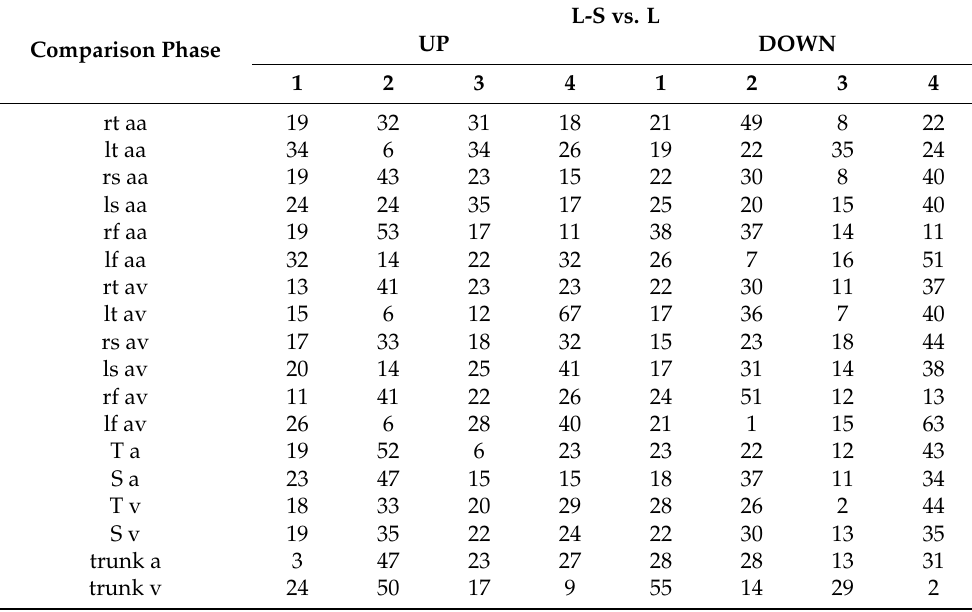
Table 4. Percentage of the significant difference points in each gait phase of each parameter